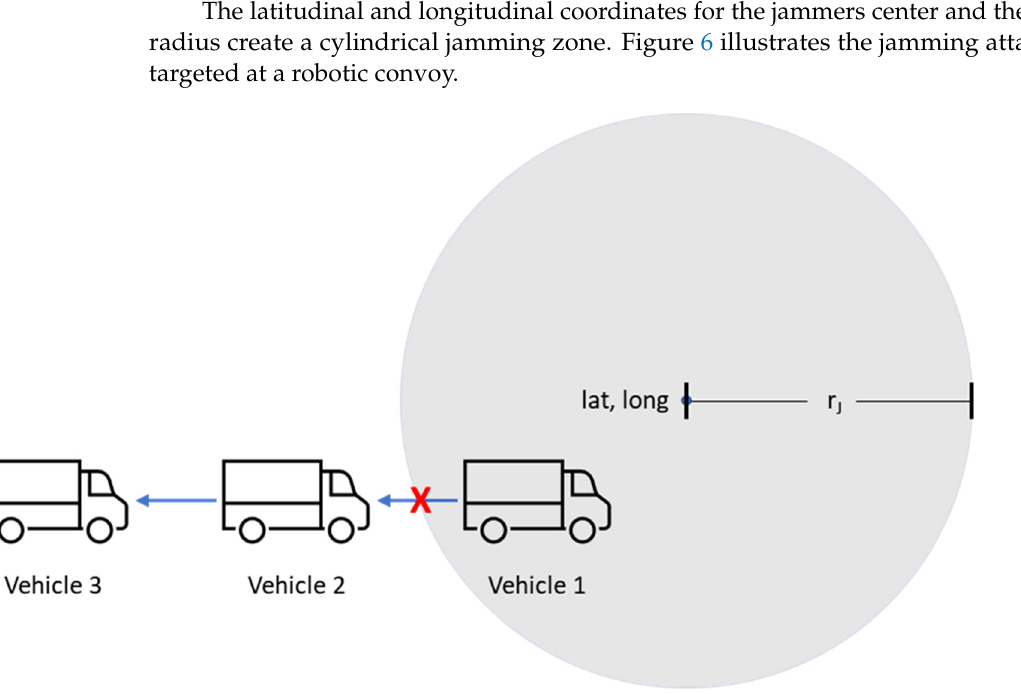
Figure 6. A convoy entering a jamming zone of radius r J centered at lat, long.